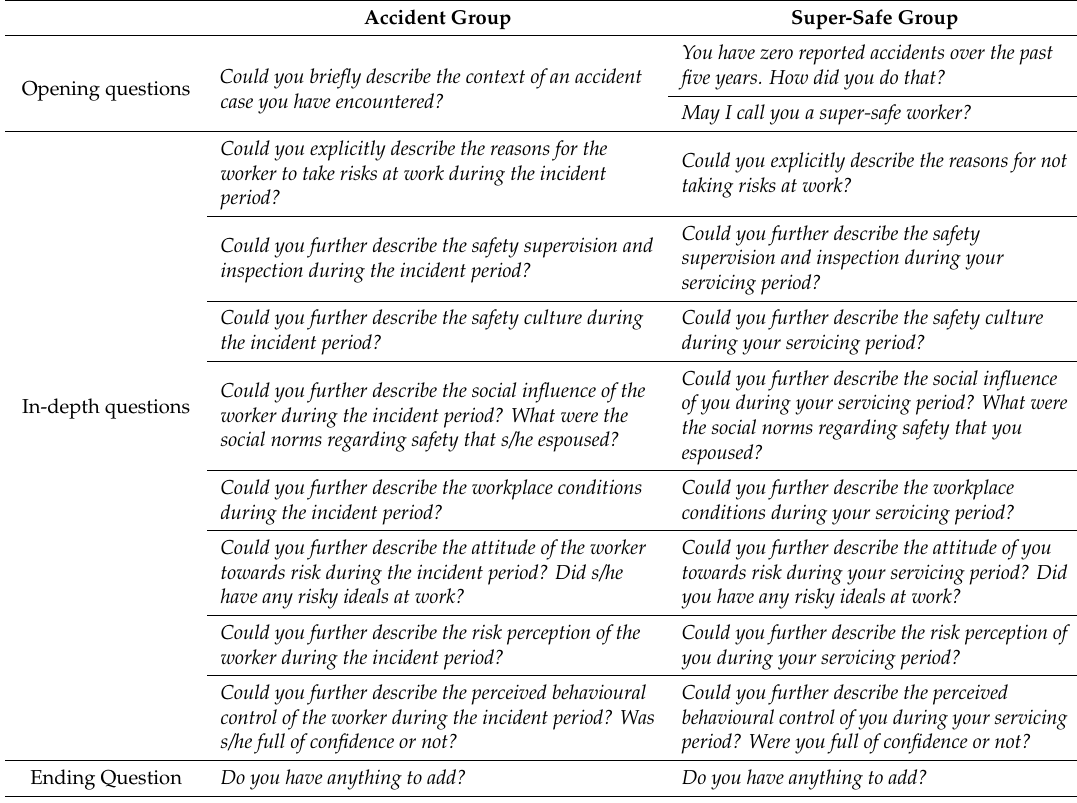
Table 1. Interview questions for the accident group and the super-safe group.